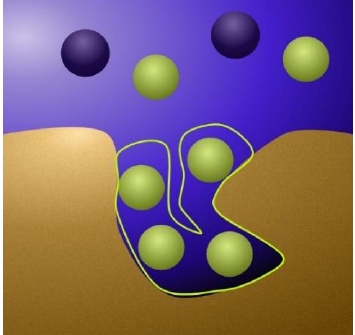
Figure 4. A detailed view of the interface between a micropore and the surrounding macropore. In the Donnan model, the water flows through the macropores, which are net uncharged. The ion adsorption occurs mainly in the micropores (the cavity in the image) and is enhanced when voltage is applied. Mathematically, the ions are considered to form a small Stern layer against the pore walls (circled green in the image).